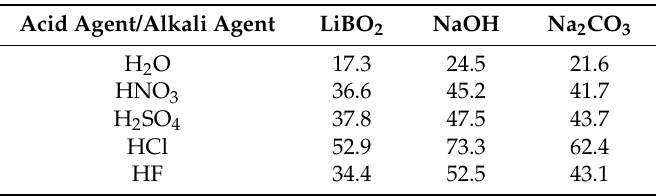
Table 3. The leaching efficiency of gallium (%) with acid concentrations 10 M at liquid-solid ratio 50 (mL/g) at 90 ◦ C for 4 h after alkali